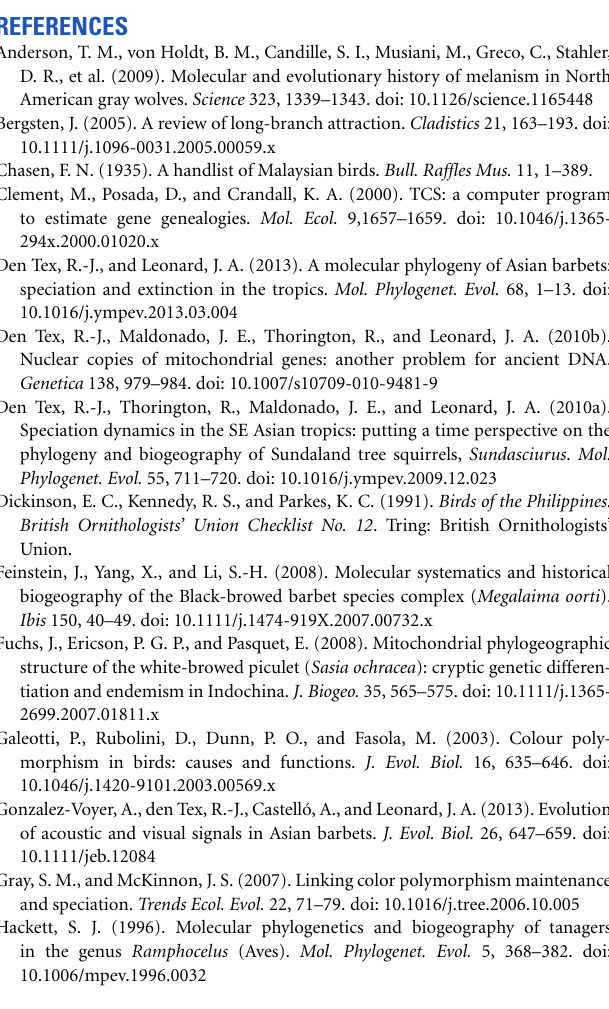
Supplementary Table 1 | ND2 and FIB7 primers used in this study. Supplementary Table 2 | Most appropriate models of sequence evolution as identified for each mtDNA marker separately and combined ( cyt b and ND2 ). Also models for each codon position is given for each